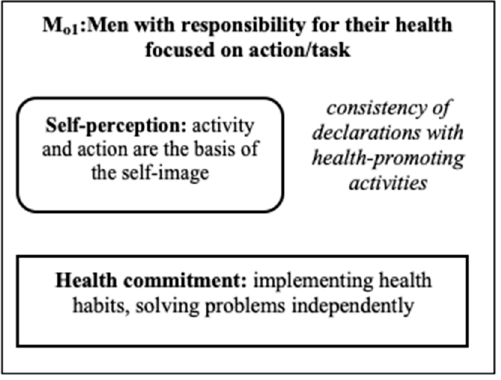
Figure 3. The sub-model of responsibility for their own health (Mo 1 ) among men.